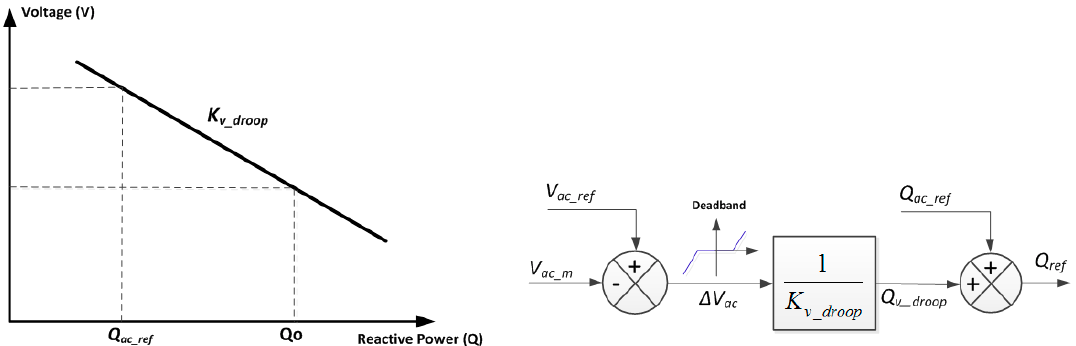
Figure 5. Q/V droop control strategy.